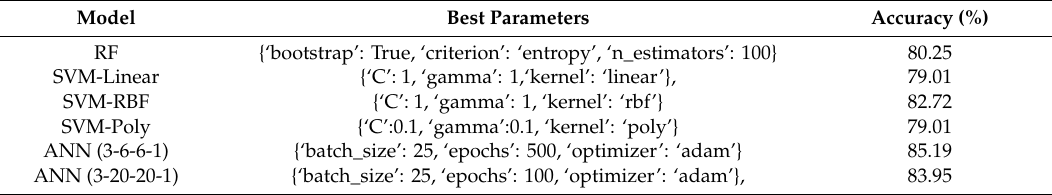
Table 15. The accuracies achieved by the machine learning (ML) models after performing grid search with 5-Fold Cross-Validation.